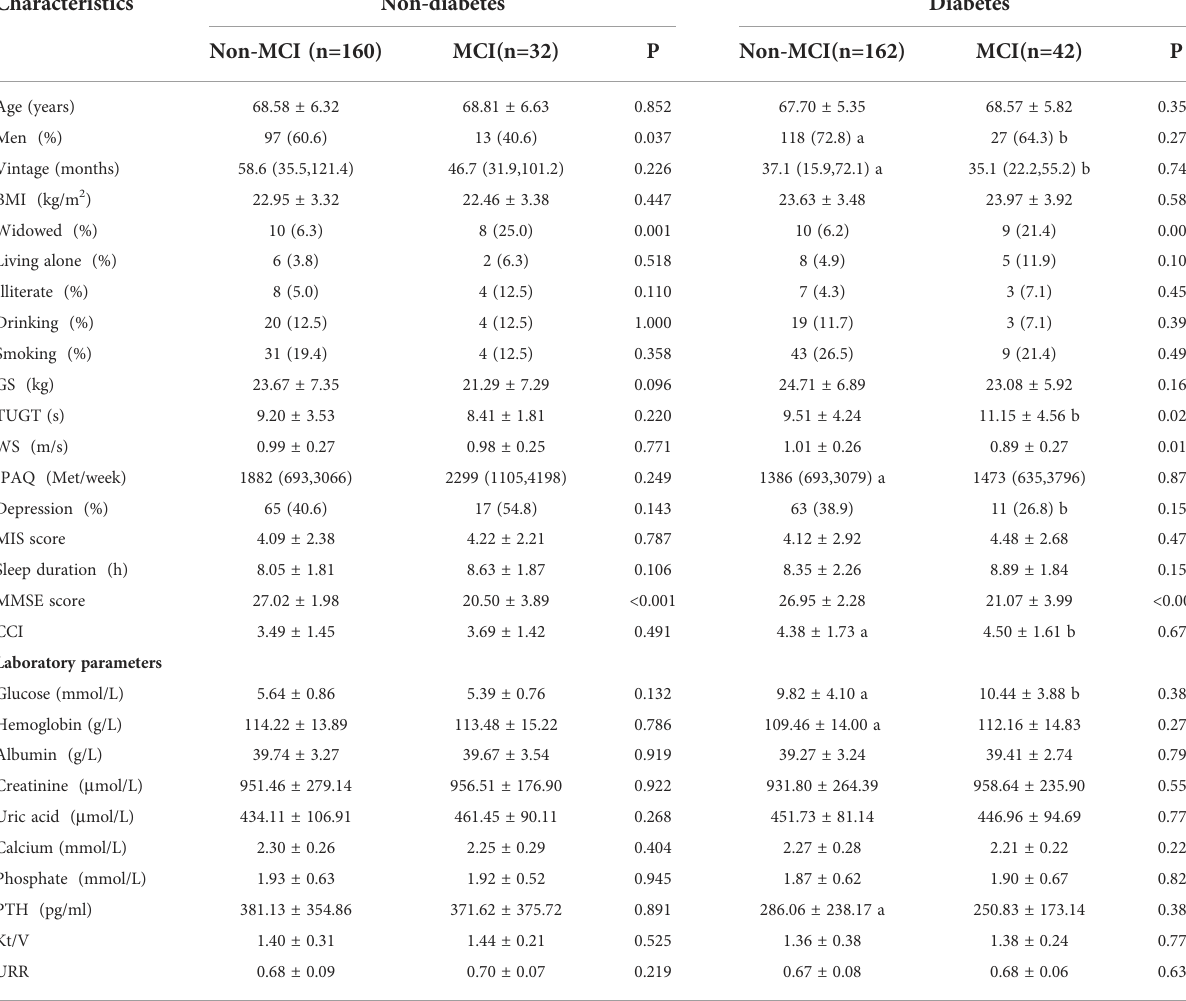
TABLE 1 Baseline data classi fi ed by diabetes and MCI in the elderly hemodialysis patients.